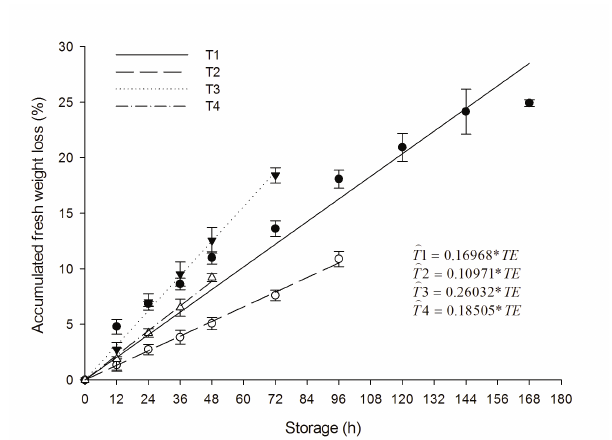
Fig. 2 - Accumulated fresh weight loss of iceberg lettuce 'Lucy Brown' submitted to the following treatments: T1) Hydro cooling for 10 min + storage at 5°C; T2) Control without hydro cooling + storage at 5°C; T3) Hydro cooling for 10 min + storage at 22°C; T4) Control without hydro cooling + storage at 22°C.